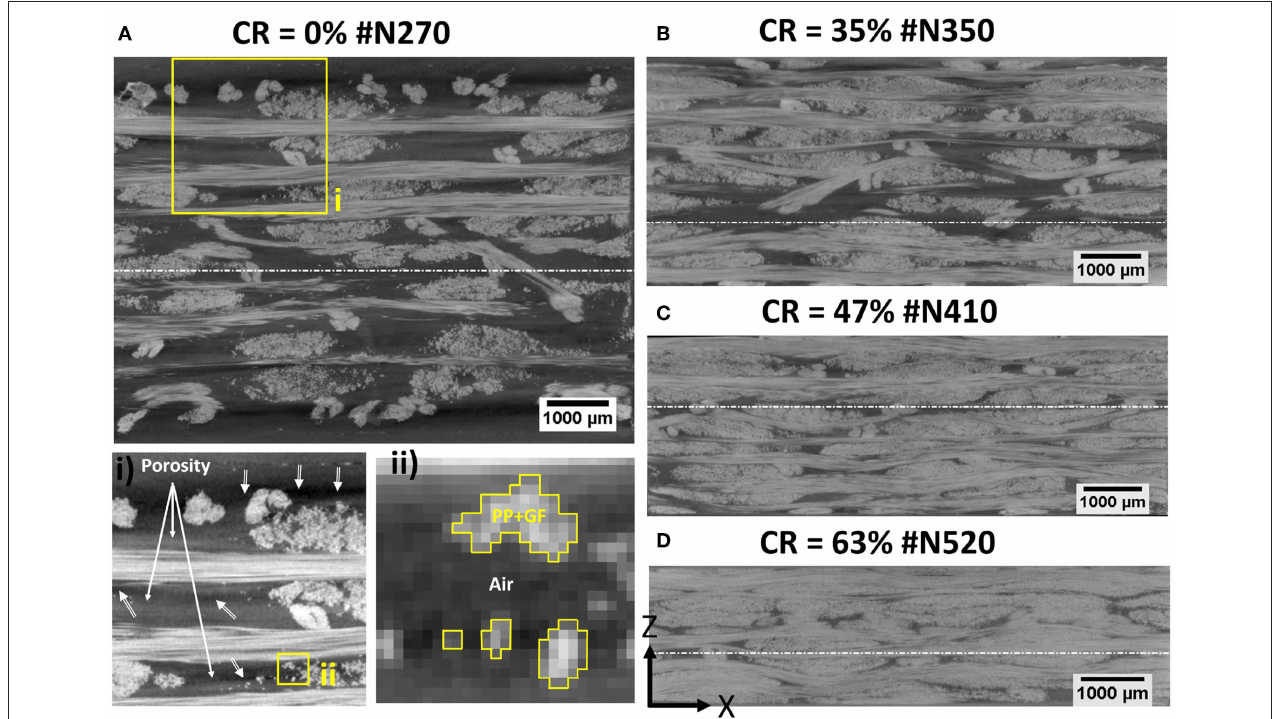
FIGURE 4 | (A–D) Representative 2D slices from four different samples. Z direction corresponds to the thickness of the manufactured plates and arrows indicate the direction of compression inside the mold in partially consolidated samples. Subdomain (i) illustrates beam hardening artifact in porosity domains. Subdomain (ii) shows the variation of pixel gray levels representing glass fibers due to partial volume